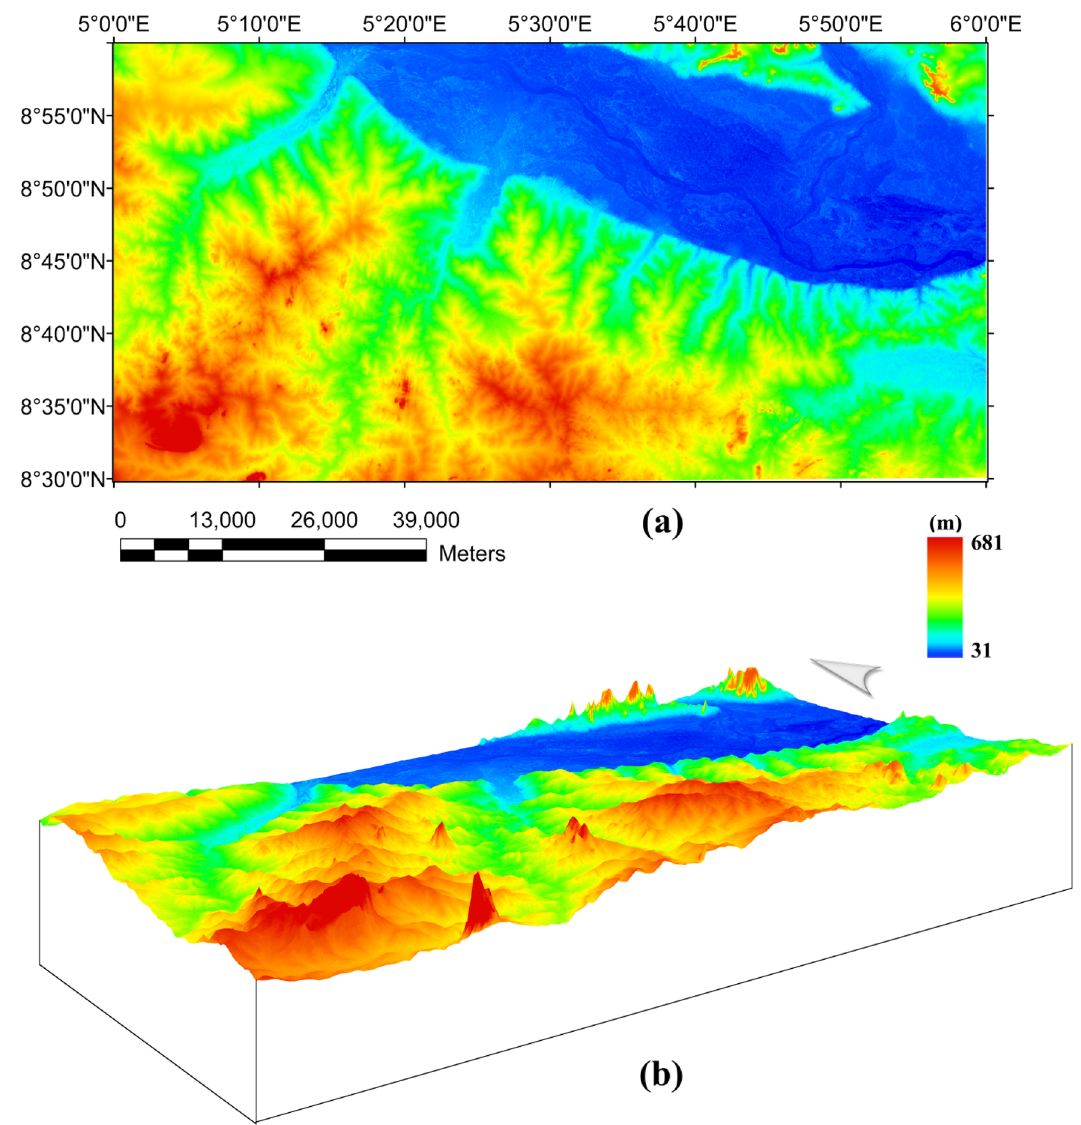
Figure 6. Digital elevation model (DEM) of southern border of the Middle Niger Basin produced from the Shuttle Radar Topographic Mission data. ( A ) 2D map view DEM of study area showing River Niger and its valley network. ( B ) 3D map view DEM of study area showing prominent topographic features. Shuttle Radar Topography Mission image courtesy of the U.S. Geological Survey. The figure was produced using ArcMap Software version 10.1 (Website: https:// deskt op. arcgis. com/ en/ of River Niger, with the distributaries exploiting the zones of weakness, in parallel alignment with the NNE- SSW Ifewara shear zone (Fig. 7). This indicates that the Ifewara shear zone controls the drainage pattern of the region and the linear fluvial meander pattern of the distributaries of River Niger. The meander pattern of the distributaries of the Niger River might have been the effect of weathering and erosion. Preferential weathering can take place along the NNE–SSW trending fractures within the Ifewara shear zone, and the river then follow this course. Intersecting fractures might have produced zigzag river traces along which the river jump from one fracture to another. Since it has been established that the Ifewara shear zone is the southern segment of the NNE- trending Kalangai-Zungeru-Ifewara shear zone associated with gold mineralization 17,22 , the results reveal possi- ble concentration of alluvium gold mineralization within the river banks of the River Niger and its distributaries. Automatic lineament extraction technique applied on the shaded-relief map (Fig. 7) resulted in the delineation of surface lineaments presented in the composite structural map (Fig. 8a). The Rose diagram (Fig. 8b) of sur- face lineaments reveals the general orientation of surface lineaments trend mainly in the N–S, NNE–SSW and NE–SW directions. In addition, the histograms (bearing and length) of surface lineaments (Fig. 8c,d) were also created. The length histogram (Fig. 8d) shows that the SRTM surface lineaments are longer compared to length histogram (Fig. 4e) of total gradient amplitude lineaments. This is because SRTM data has a higher spatial reso- lution (30 m) than the aeromagnetic data, which leads to the detection of various longer lineaments.